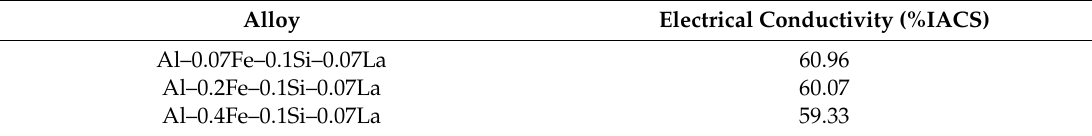
Table 2. Electrical conductivity of the Al–xFe–0.1Si–0.07La